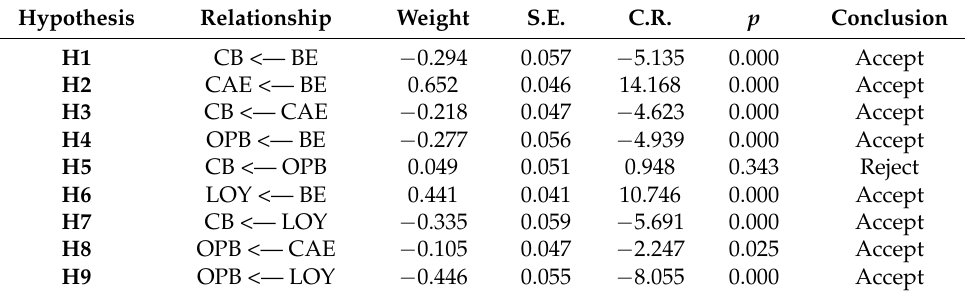
Table 4. Result of SEM analysis for relationships in the model.